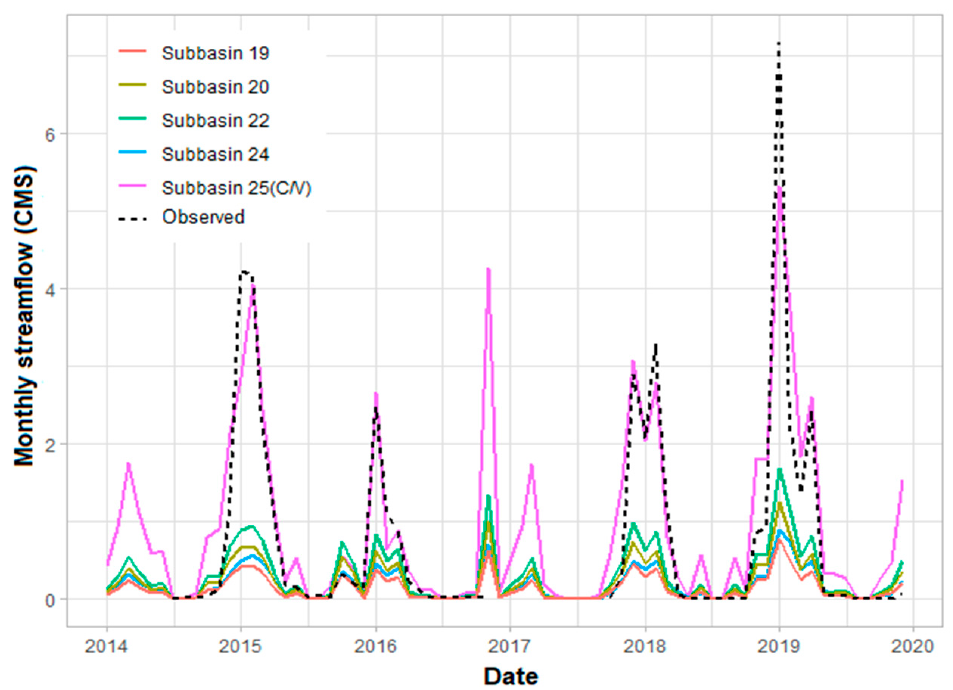
Figure 7. Measured and simulated monthly discharge at Tsiknias River contributing tributaries during 2014–2019.